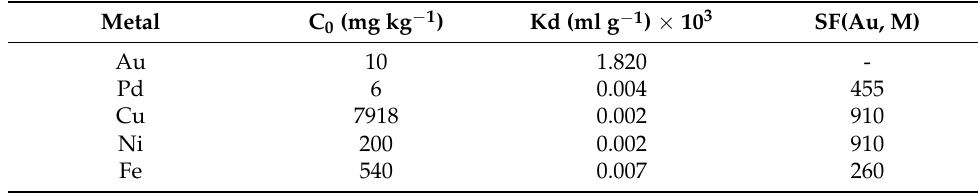
Figure 10. ZrO 2 -L 6 for adsorption of Au and other metals in real e-waste water solution. Figure 10. ZrO 2 ‐ L 6 for adsorption of Au and other metals in real e ‐ waste water solution. Table 7. Values of the initial concentration, the distribution coefficient, and the separation faction of Au compared to other competing metals present in real